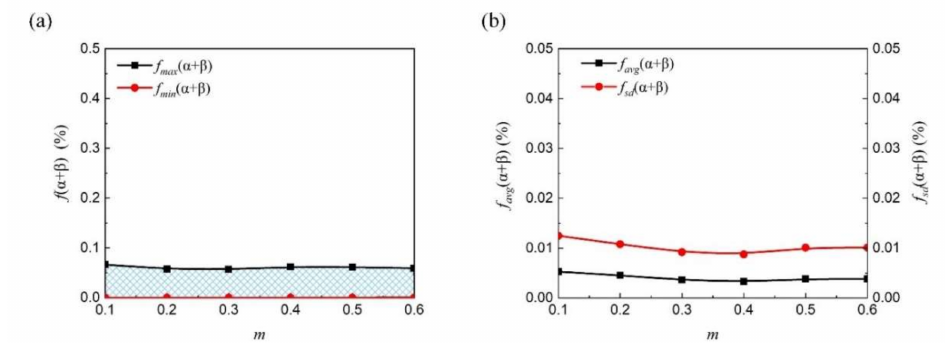
Figure 8. ( a ) f max ( α + β ) and f min ( α + β ) as well as ( b ) f avg ( α + β ) and f sd ( α + β ) variations with the increment of m .